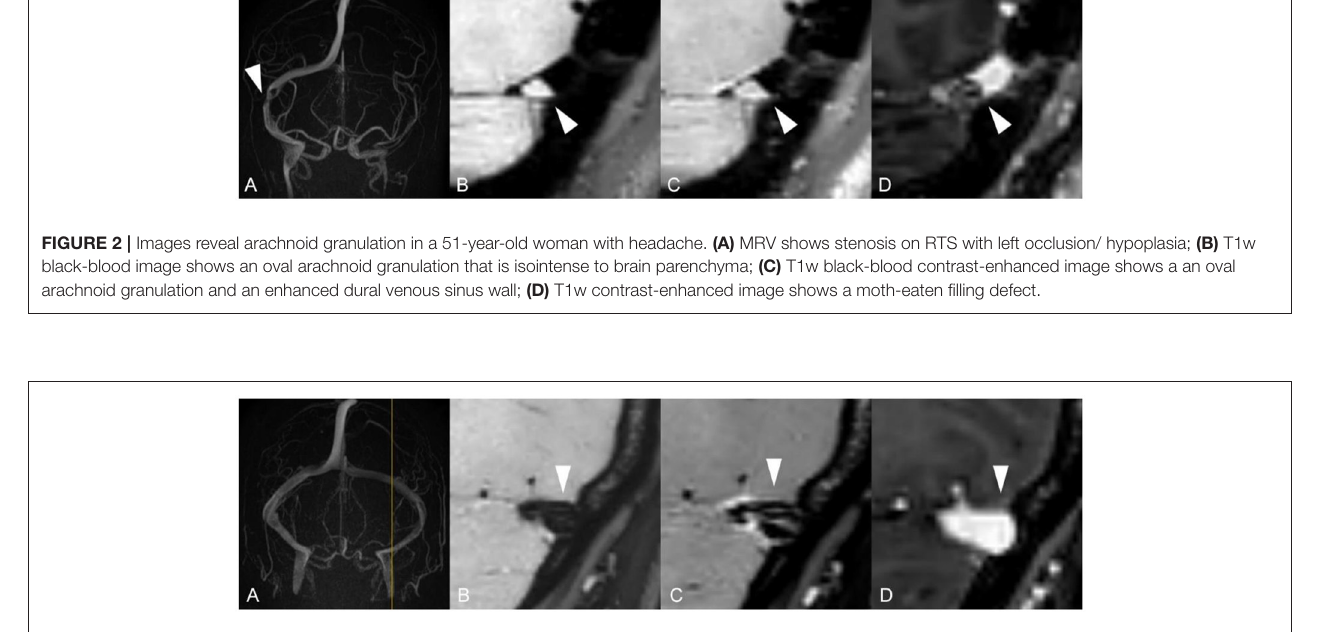
FIGURE 3 | Images reveal a fibrous septum in 36-year-old woman with tinnitus and diplopia. (A) MRV shows normal venous sinus; (B, C) T1w black-blood image and T1w black contrast-enhanced image shows fibrous septum in DVS lumen; (D) T1w contrast-enhanced image shows a normal lumen without any filling defect.